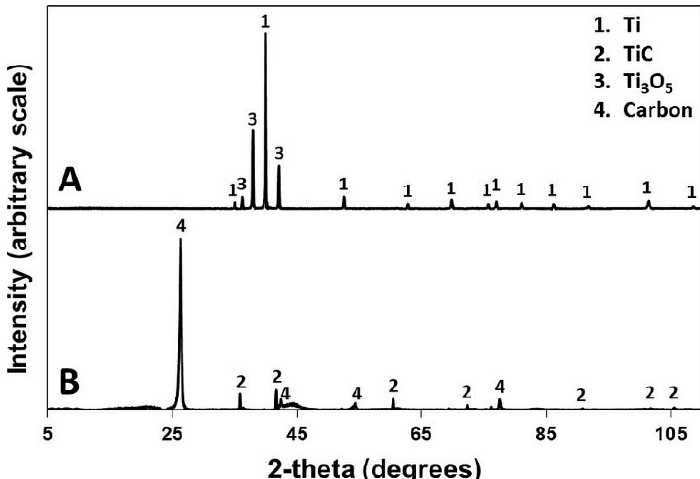
Fig. 3 . X-ray diffractograms of the titanium coating surface (A) and the coating-graphite interface (B). The coating surface mostly contains titanium and titanium oxide, whereas the interface is composed of titanium